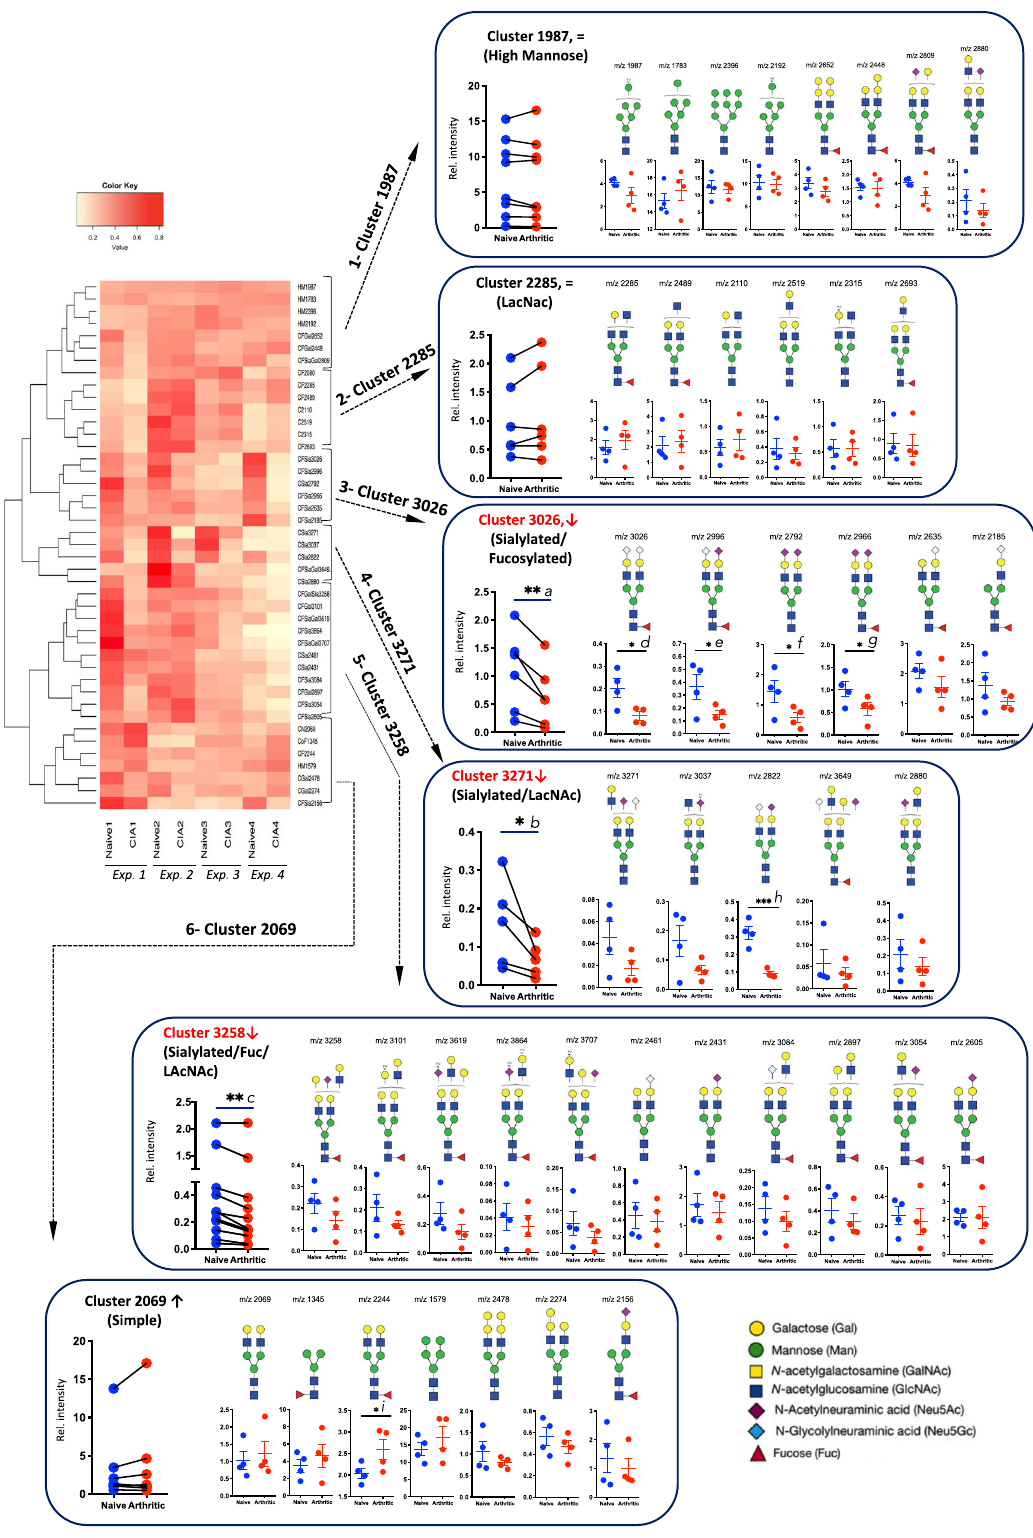
Synovial fi broblast subsets are differentially sialylated . The discovery of individual subsets of SFs has revolutionized our understanding of fi broblast biology in RA. Single-cell tran- scriptomic experiments have shown that fi broblast subsets localize to speci fi c regions in the synovium contributing to different aspects